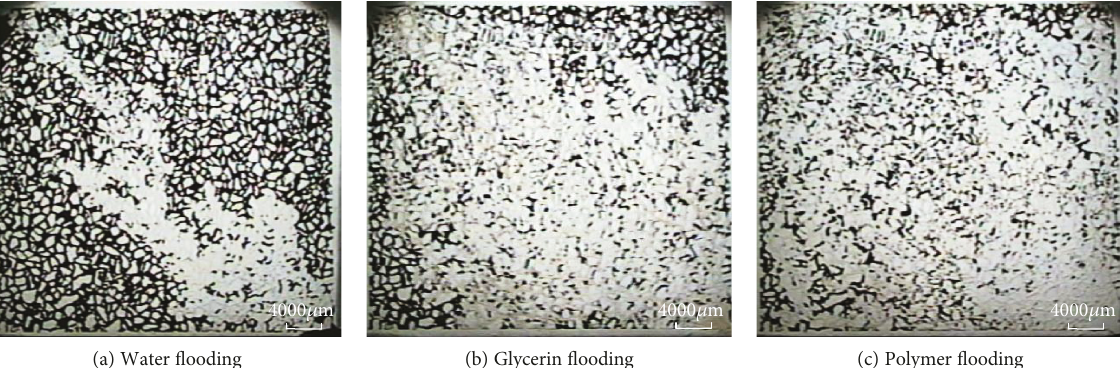
Figure 8: Residual oil distribution of glycerin fl ooding and viscoelastic polymer fl ooding with the same viscosity (40 mPa · s) at a water displacement sweep e ffi ciency of 20% (the dark area is oil, and the lighter the color is, the lower the saturation is; the light area represents the displacing fl uid).